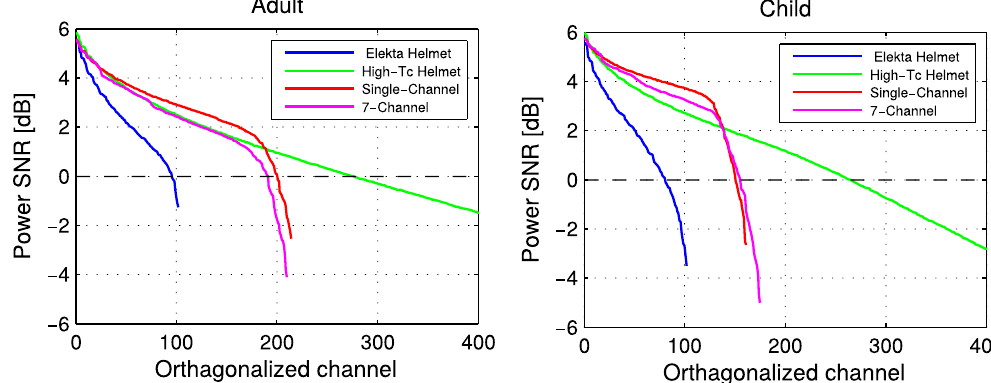
Figure 2. Power SNRs for all MEG arrays over orthogonalized channels for an adult (left) and a child (right) brain with optimistic high- T